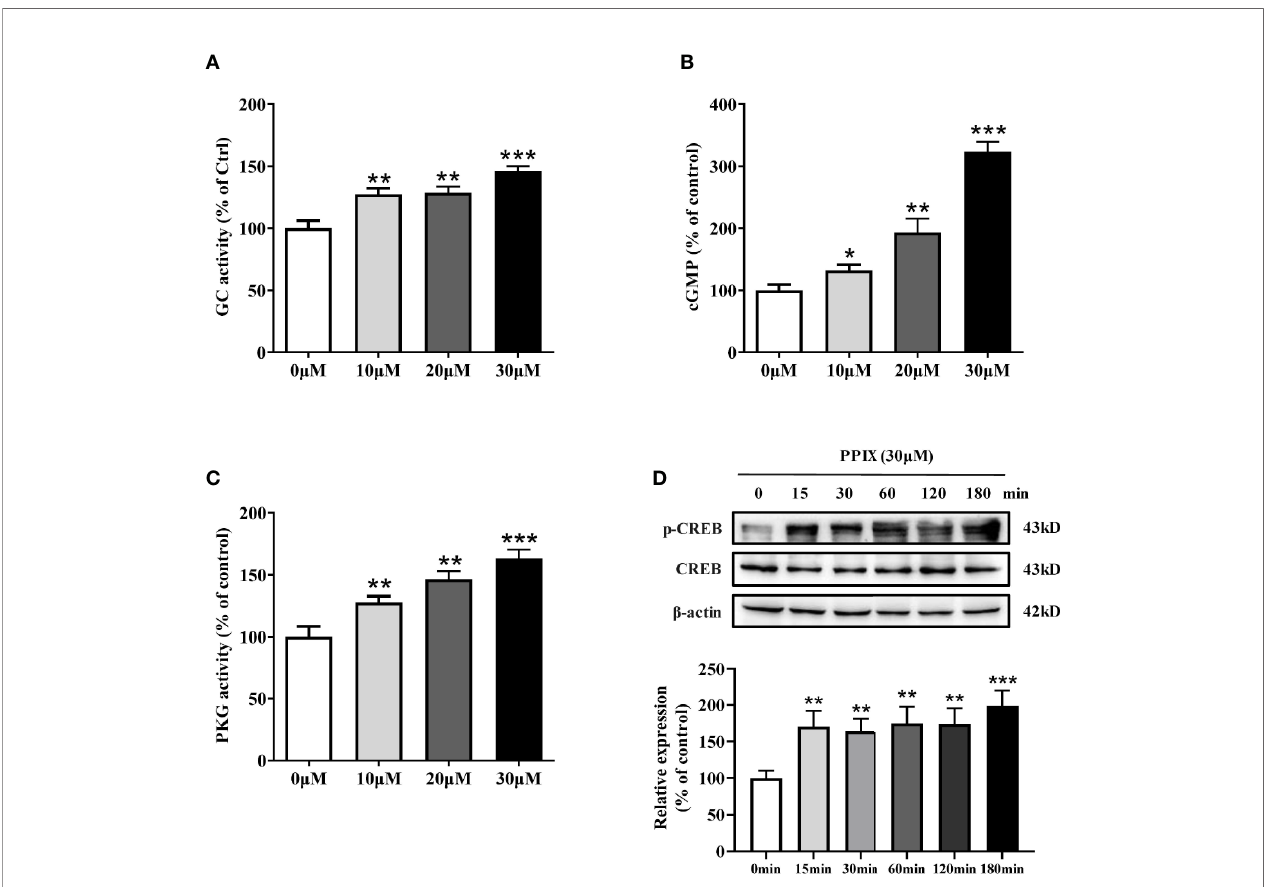
FIGURE 4 | The effects of PPIX on the activity of GC/cGMP/PKG signaling pathways in melanocytes. (A) Guanylate cyclase (GC) activity in melanocytes treated with PPIX was measured. Effect of PPIX on cellular cGMP levels (B) and PKG activity (C) in melanocytes was examined after cells were treated with PPIX. (D) Quanti fi cation of cAMP-response element-binding protein (CREB) and phosphorylation of CREB (p-CREB) protein expression levels were evaluated by western blotting. Data are expressed as the mean ± SEM (n = 3). *p < 0.05, **p < 0.01, ***p < 0.001 versus non-treated